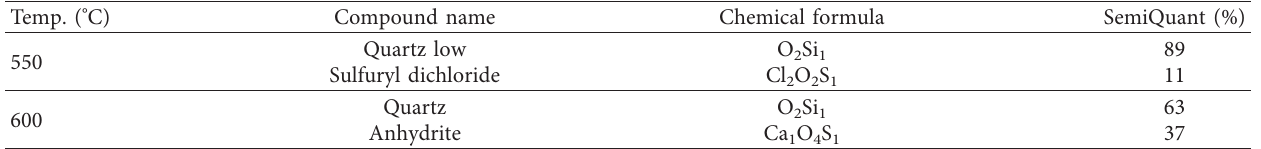
Table 11: XRD analysis of BD-3B